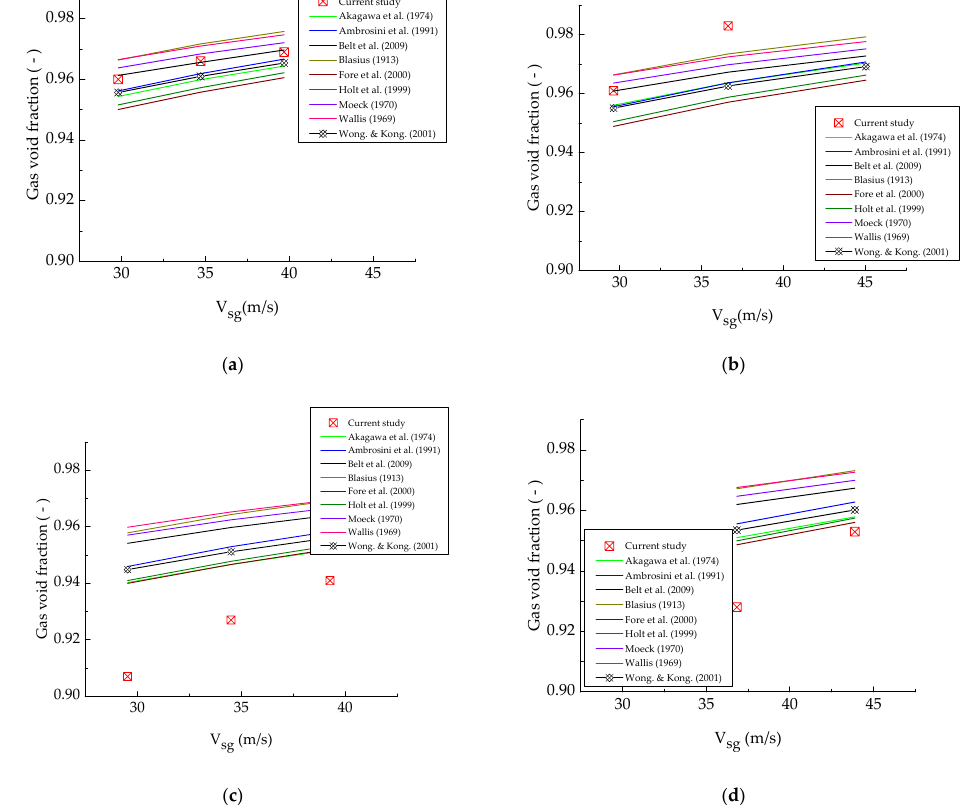
Figure 8. Comparison of experimental gas void fraction with predictions of two-fluid model using selected 𝑓 (cid:3036) correlation at 100 ( a , b ) and 200 ( c , d ) mPa s. Equation (16) explains the observed characteristics of the predictions in Figures 8 and 9. The equation expresses the mathematical relationship showing that void fraction as a function of superficial gas and liquid velocities as well as accurate predictions of both